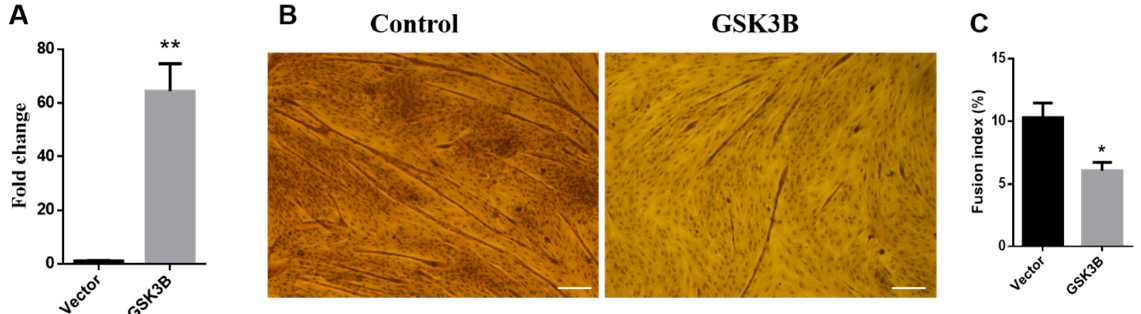
Figure 1. GSK3 β decreases myogenic differentiation in sheep SMSCs. ( A ) The expression level of GSK3 β in sheep SMSCs. Cells were transfected with the GSK3 β overexpression vector (pcDNA3.1- GSK3 β ). ( B ) Myotube formation was visualized by an inverted light microscope and ( C ) quantified by measuring the fusion index at 8 days of differentiation. The fusion index (%) is the ratio of fusional nuclei to the total cell nuclei within the same field of vision. p < 0.05 (*) and p < 0.01 (**) relative to control (pcDNA3.1+).